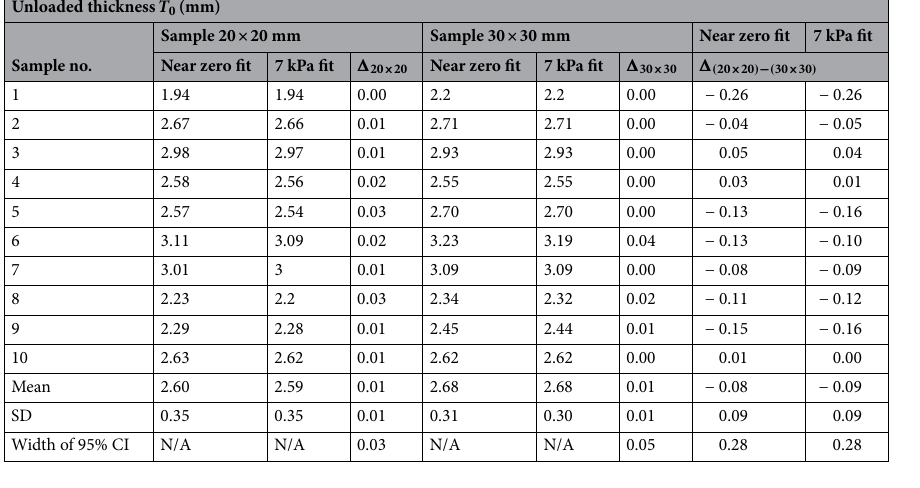
Table 2. Estimated unloaded thickness for all samples. Unloaded thickness was fitted from line fitting to either the first three points or to the two points at 1 and 7 kPa. Last two columns show deviations between smaller and larger samples for both methods. CI stands for confidence interval.